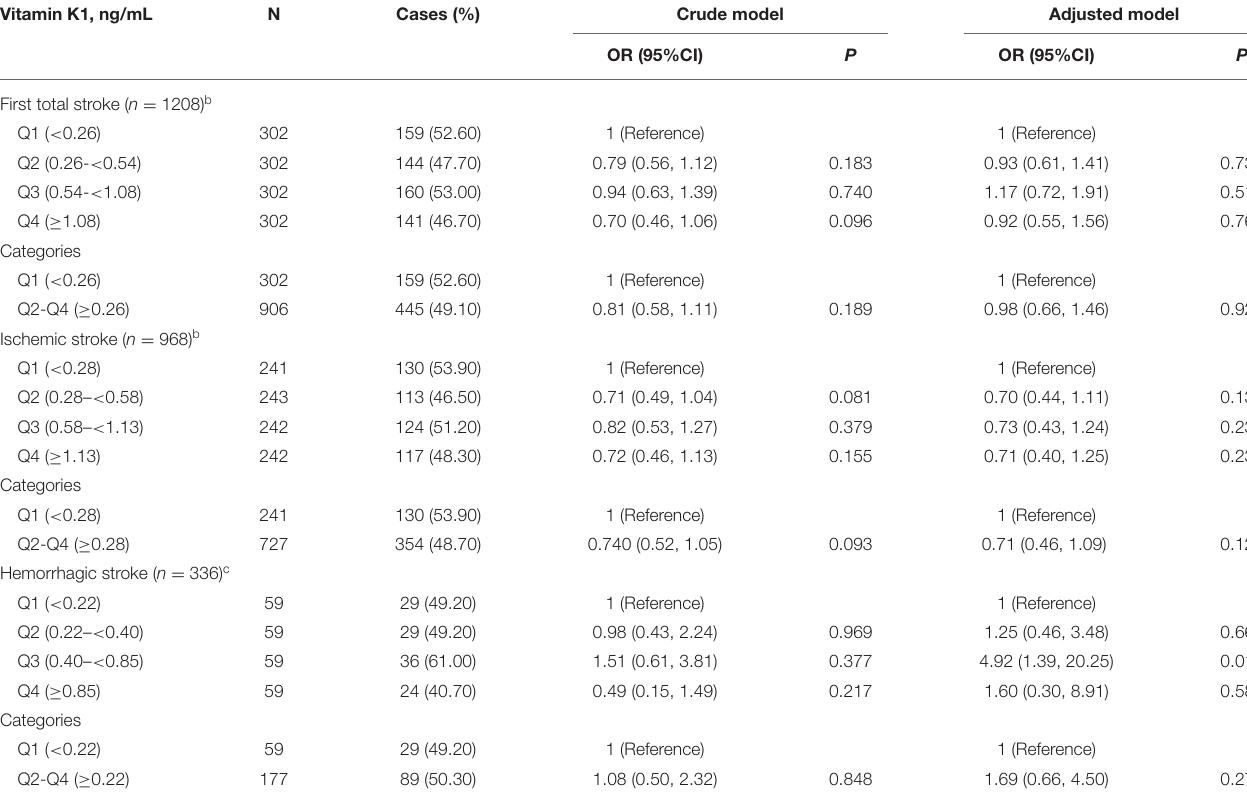
TABLE 2 | The relationship of baseline plasma vitamin K1 with the risk of stroke (total and subtypes) a . Vitamin K1, ng/mL N Cases (%) Crude model Adjusted model OR (95%CI) P OR (95%CI)